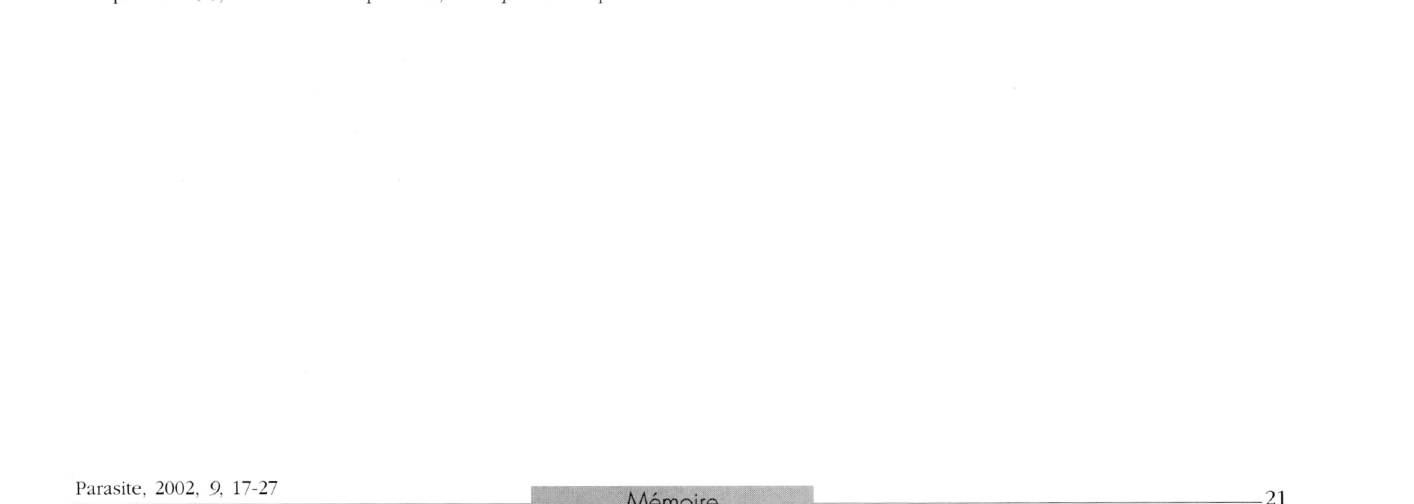
Parasite, 2002, 9, 17-27